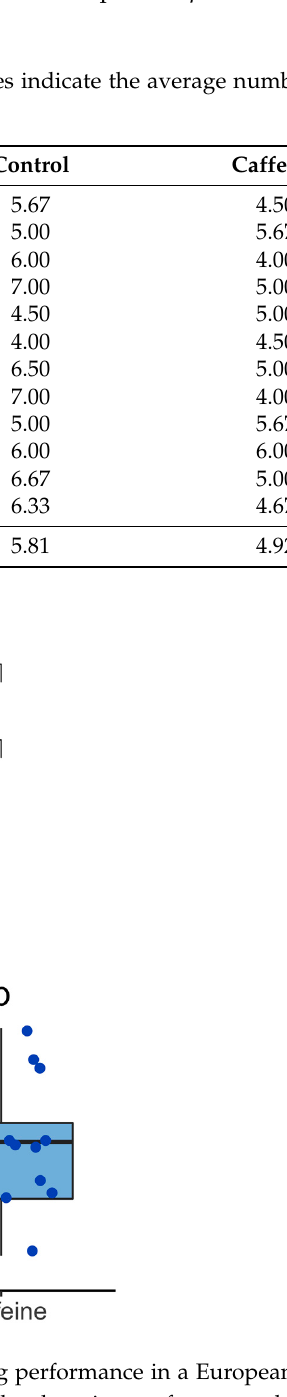
Figure 2. The effect of caffeine and dopamine on learning performance in a European honeybee colony, Apis mellifera . Caffeine-treated bees showed a higher learning performance than the control, requiring less training trials until conditioned to the stimulus. Significance was calculated using repeated measures ANOVA and differences between groups were estimated using Multiple Com- parisons of Means (Tukey